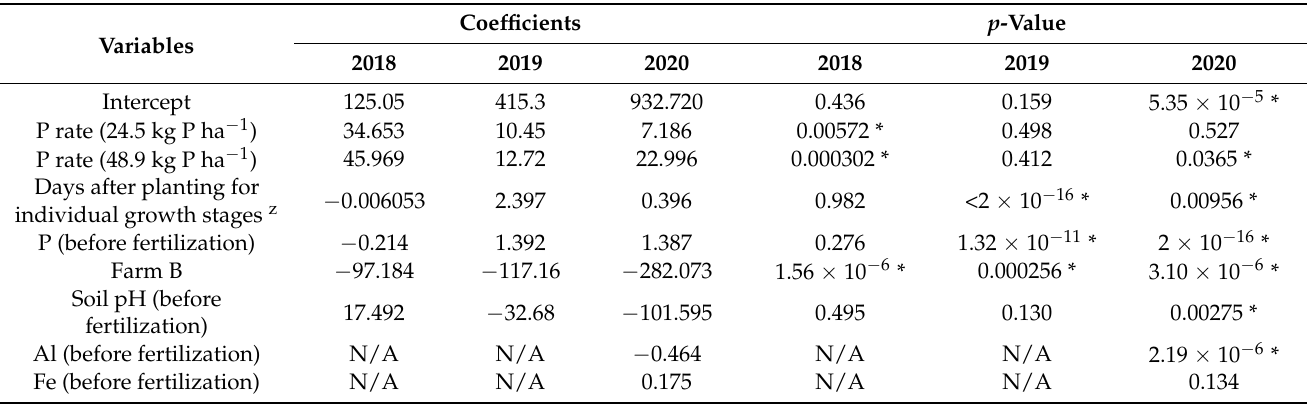
Table 6. Regression of P content on P rate, days in the growing season, farm, soil pH, and nutrient contents before fertilization for the years 2018, 2019, and